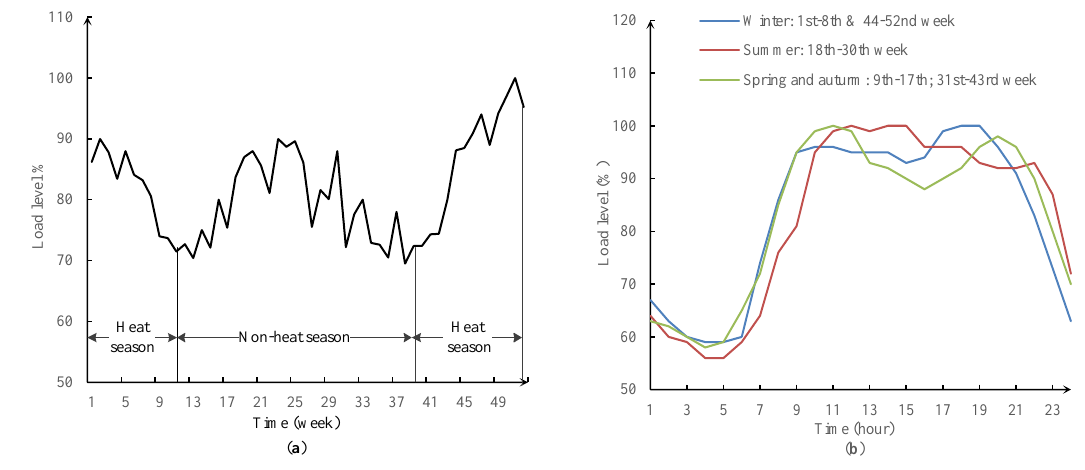
Figure 7. The weekly ( a ) and hourly ( b ) electric load